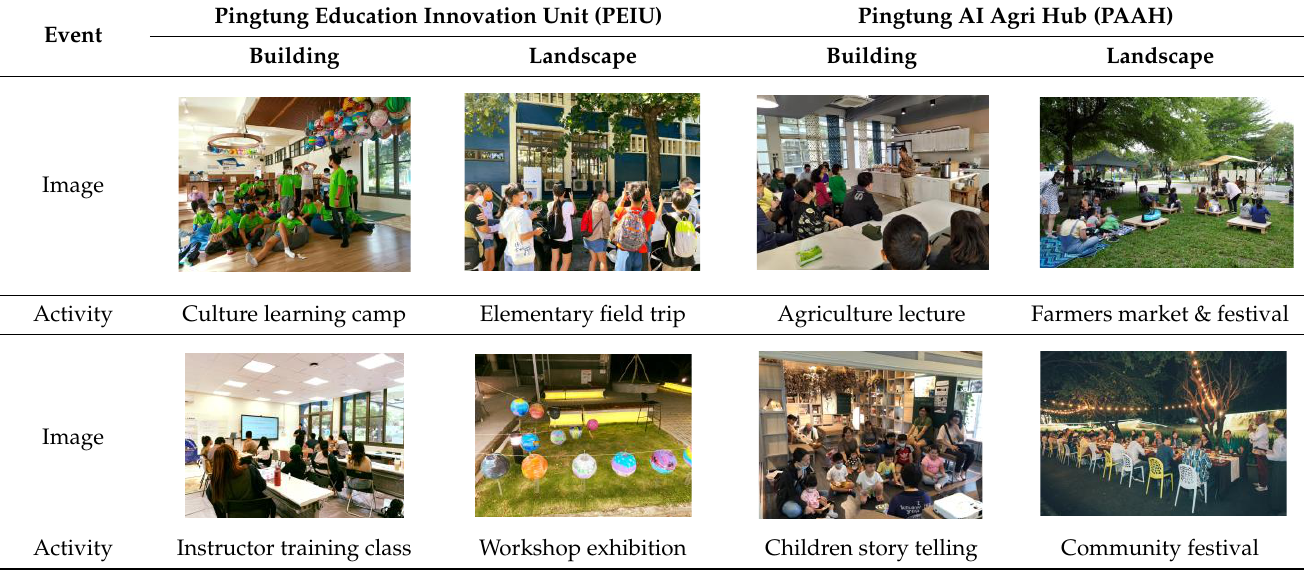
Figure 20. Concept for an Interdisciplinary Network System. 5. Conclusions and Recommendations 5.1. Conclusions